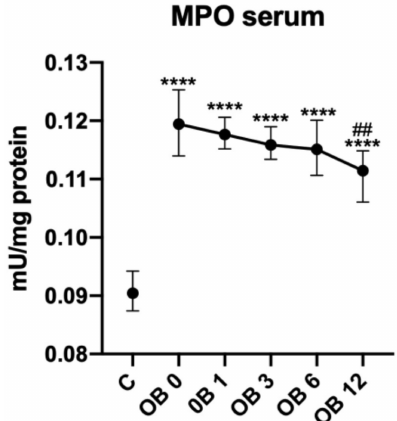
Figure 1. Serum myeloperoxidase (MPO) activity of control (C) and morbid obesity (OB); data given as median and 95%Cl; **** p < 0.0001 indicates significant di ff erences from the control (C); ## p < 0.01 indicates significant di ff erences from the morbid obesity before laparoscopic sleeve gastrectomy (OB 0); morbidly obese patients before (OB 0), as well as 1 month (OB 1), 3 months (OB 3), 6 months (OB 6) and 12 months (OB 12) after sleeve gastrectomy; myeloperoxidase